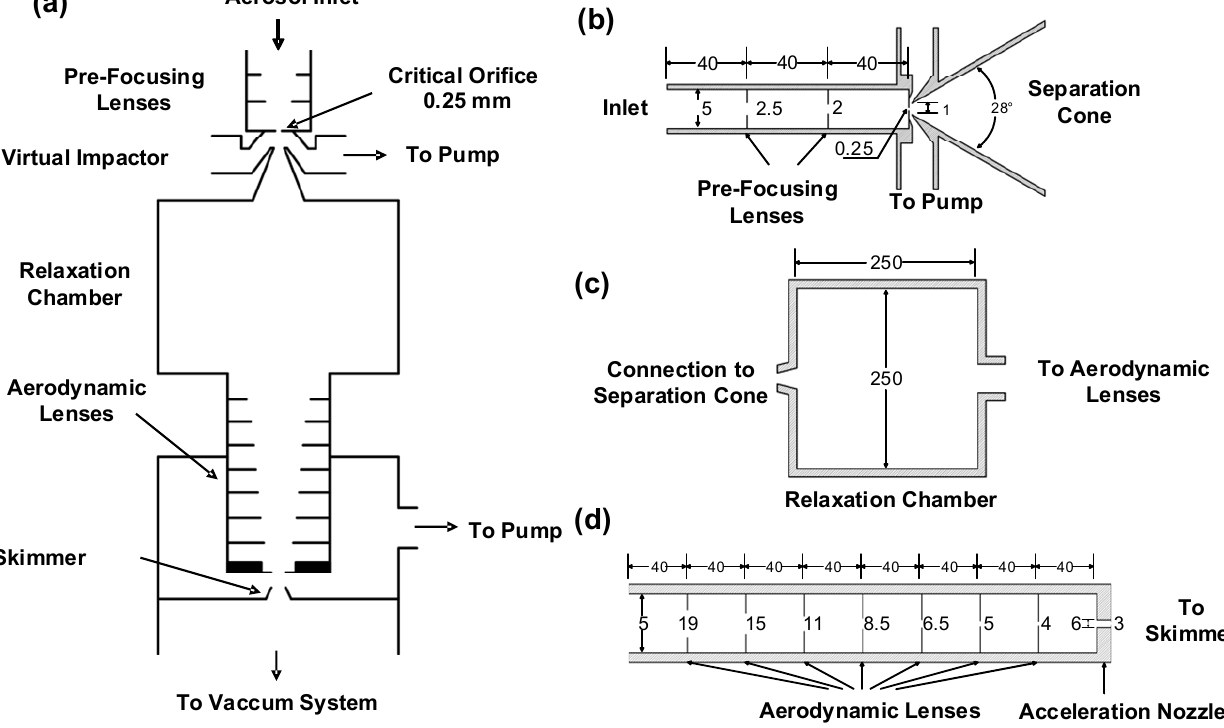
Figure 1. ( a ) Schematic diagram of the wide-range aerosol inlet system; ( b ) the pre-focusing leans and separation cone; ( c ) relaxation chamber; ( d ) aerodynamic lens.